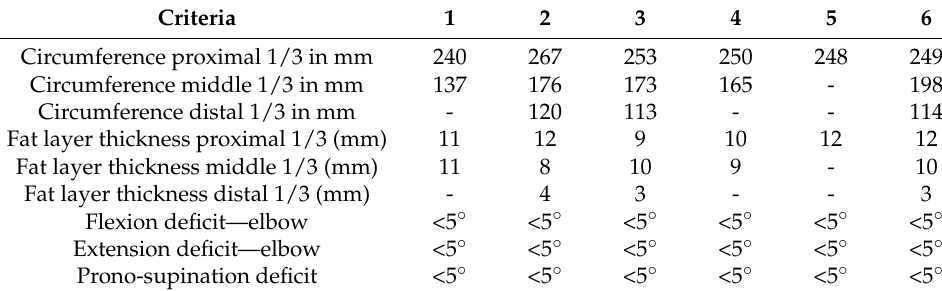
Table 3. Anatomical characteristics of the amputation stumps.